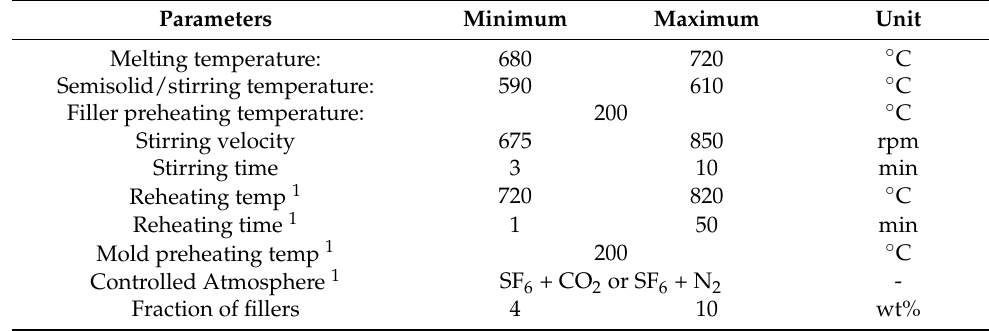
Figure 6. Compocasting process scheme for MMSFs. Table 6. Range of values of the parameters governing the compocasting (CC) process.